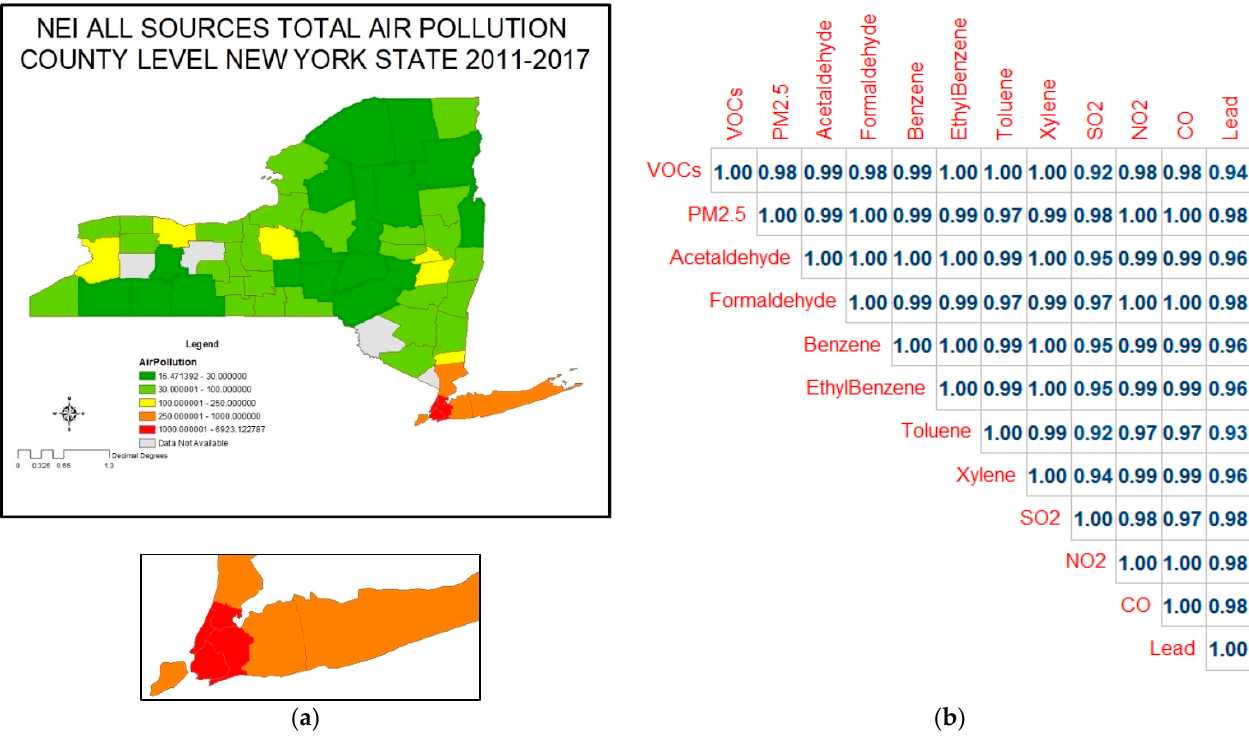
Figure 2. ( a ) Total air pollution per square mile by county; ( b ) correlation between 12 air pollutants